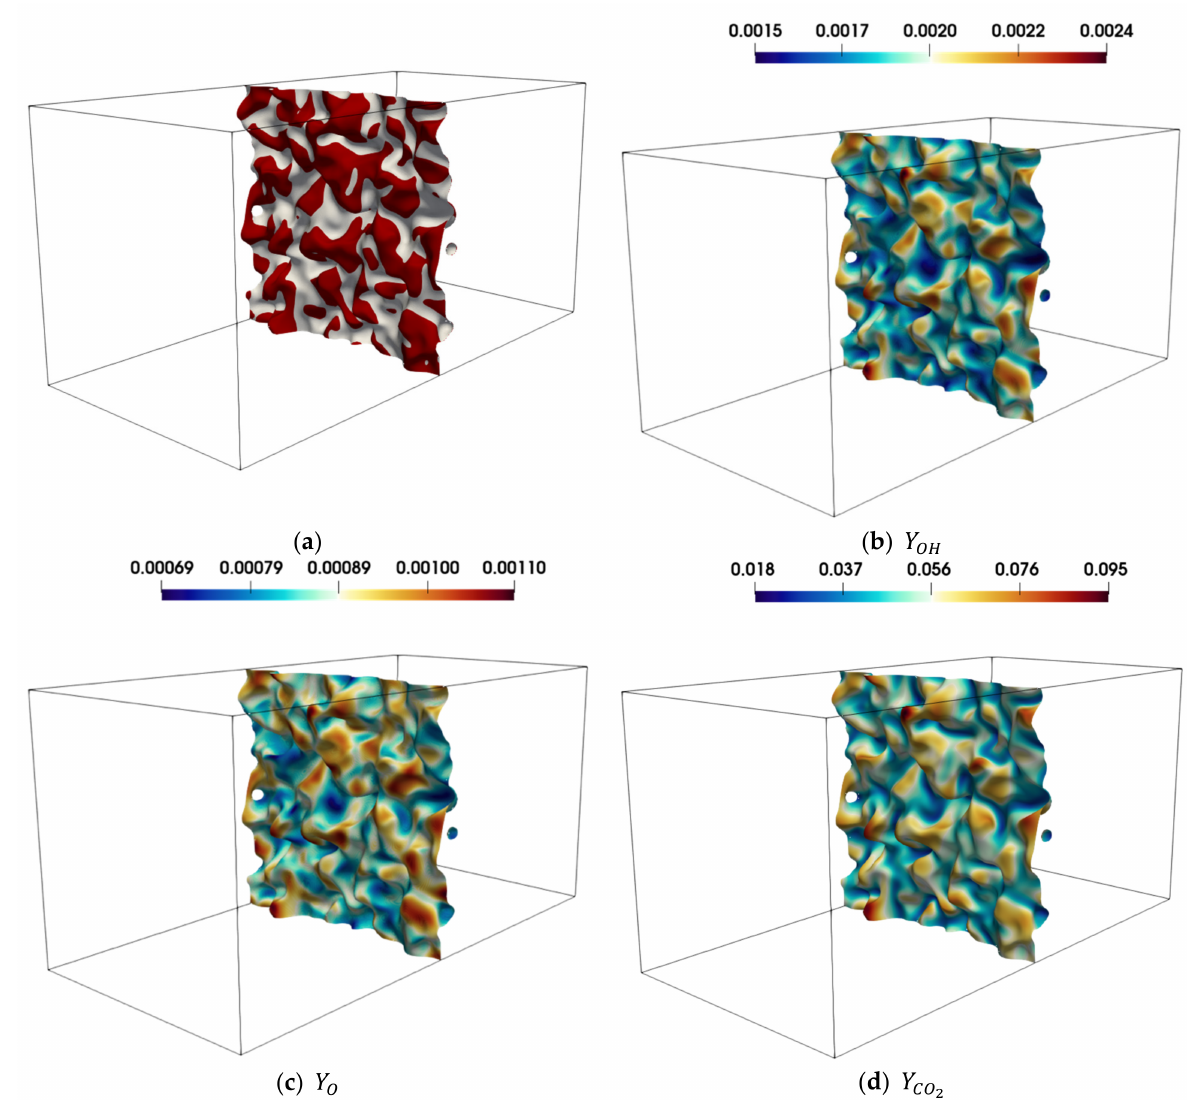
Figure 21. ( a ) Simultaneous plot of isosurfaces of reaction progress variable c = 0.8 for H 2 O (grey) and temperature (red) where the temperature isolevel corresponds to the mean temperature value of the c = 0.8 H 2 O-based reaction progress variable isosurface. ( b – d ) Isosurfaces of reaction progress variable c = 0.8 for H 2 O coloured with mass fractions of ( b ) OH ( c ) O ( d ) CO 2 . Red colour represents high concentration blue colour represents low concentration (refer to the colour bars). Results are exemplarily shown for case